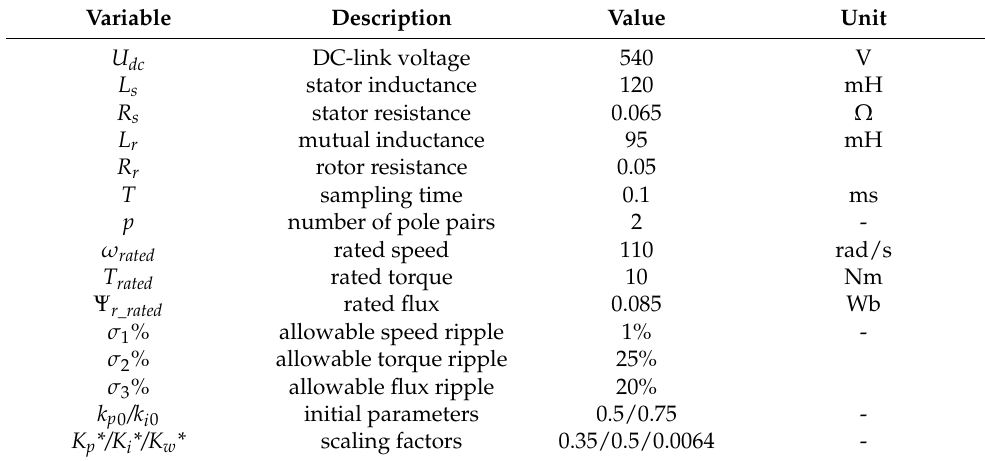
Table 4. Parameters of IM drive